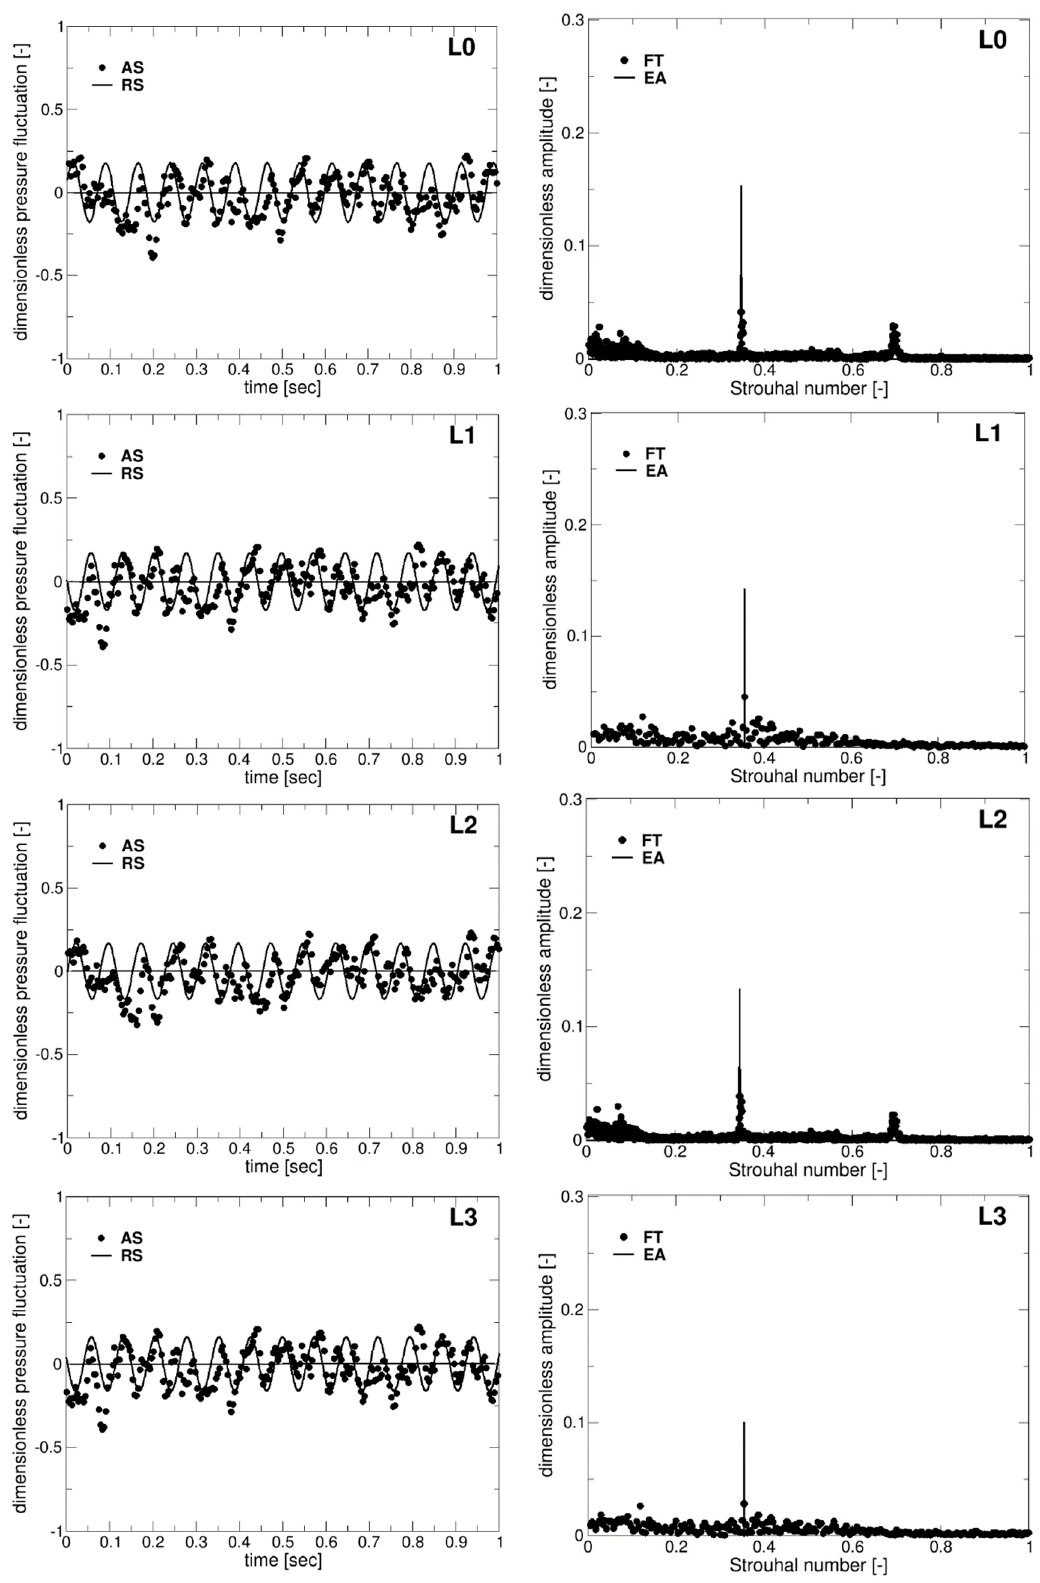
Figure 6. Pressure fluctuation on all levels with shutter area ratio of 70% (d = 0.088 m): acquired signal (AS) vs. reconstructed signal (RS) ( left ) and its Fourier spectrum (FT) vs. equivalent amplitude (EA) ( right ).